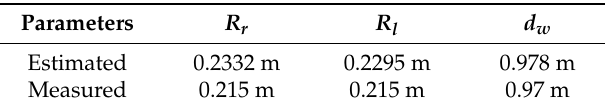
Table 1. Parameter